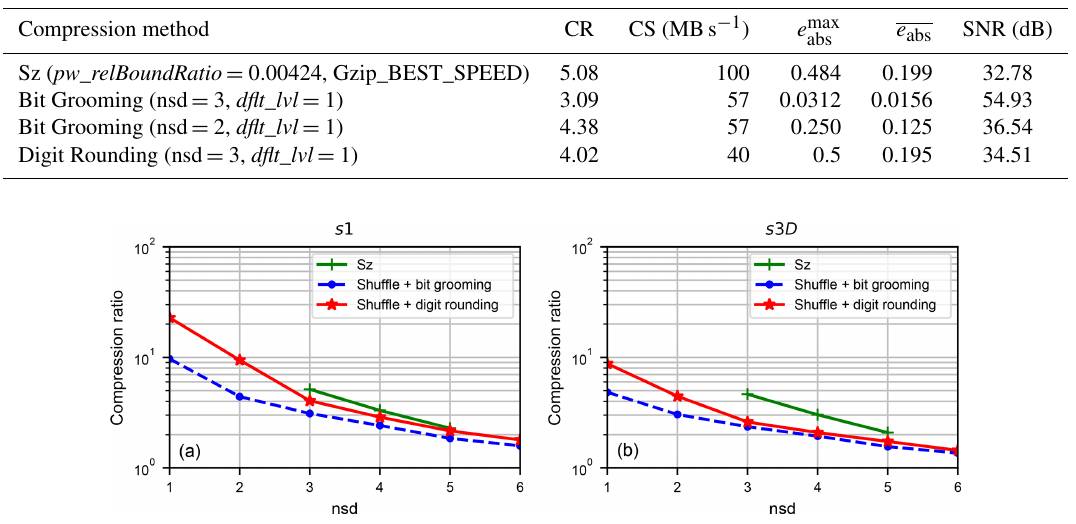
Figure 6. Compression ratio as a function of the user-specified number of significant digits (nsd) for the Sz, Bit Grooming and Digit Rounding algorithms, on the s1 dataset (a) and s3D dataset (b)